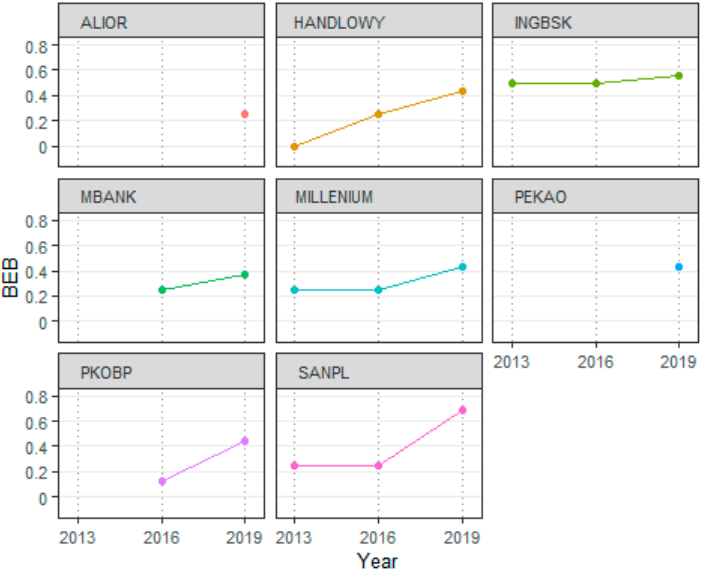
Figure 2. Changes in the BEB index in 2013–2019. Source: Own contribution of the authors.